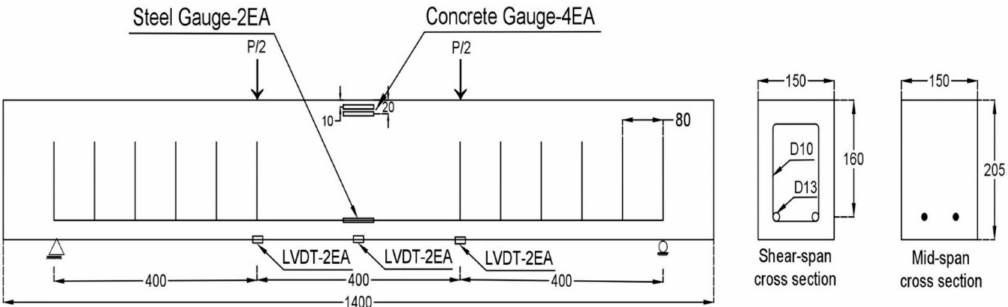
Figure 1. Reinforcement detail and cross-section of the RC